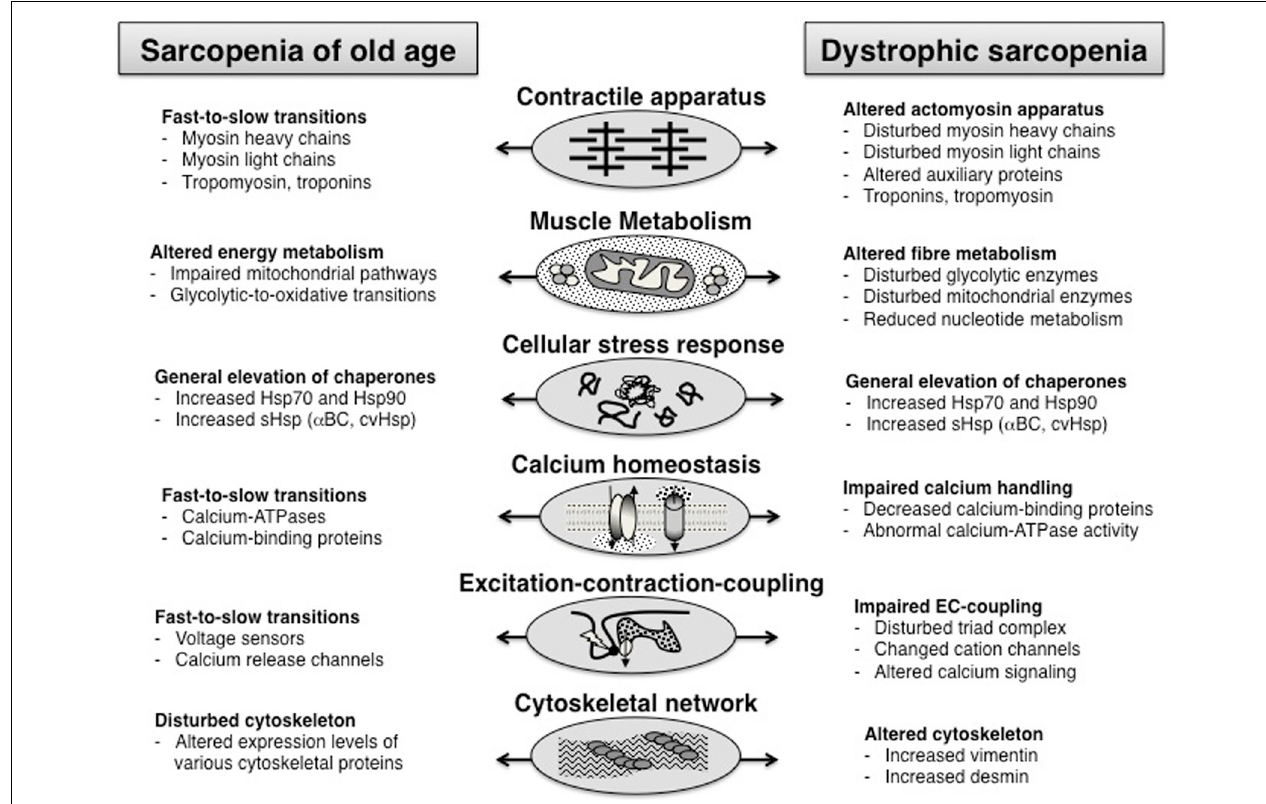
FIGURE 2 | Overview of proteome-wide alterations in the muscle tissue during sarcopenia of old age vs. dystrophic